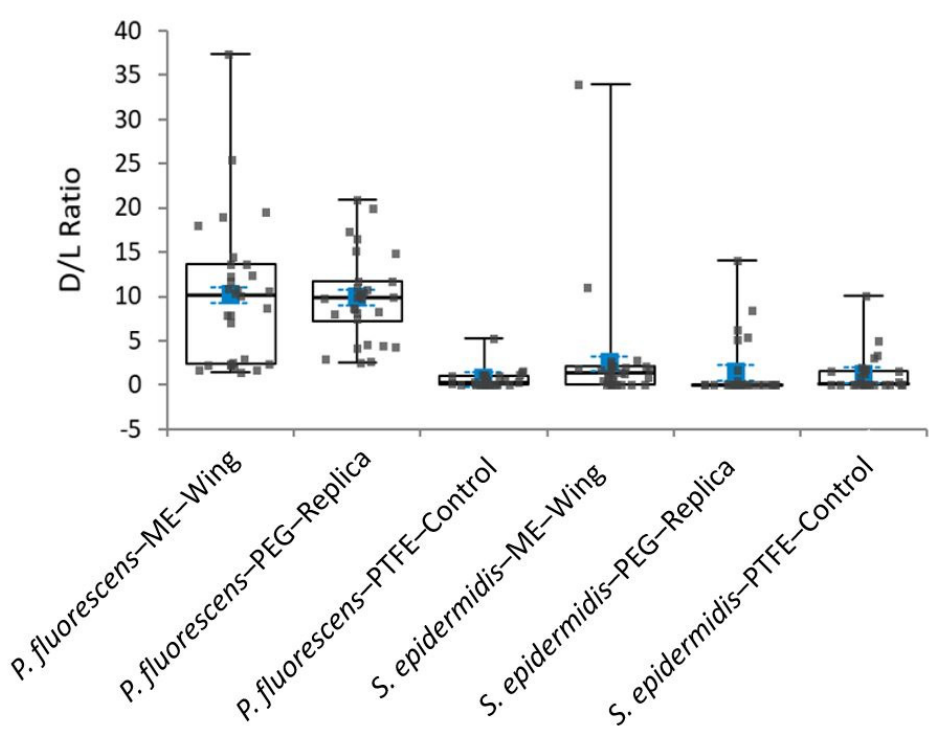
Figure 3. Ratio of dead/damaged cells to live cells of adhered Pseudomonas fluorescens and Staphylococcus epidermidis cells onto microstructured ME wing, PEG replica and a non-structured PTFE control surface. Cell dead/live ratios (D/L Ratio) were calculated by dividing surface coverage data from SYTOX Green-positive and propidium iodide-positive with mCherry-tagged cells and Syto-9-positive cells, respectively. Box plots show the interquartile range, black whiskers indicate standard deviation, and black lines indicate median. Internal blue dots represent the mean and the internal error bars represent standard error of the mean.